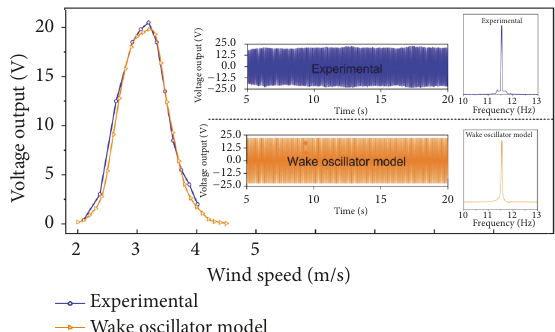
Figure 4: Comparison of experimental and theoretical results for VIVPEH with smooth cylinder shaped bluff